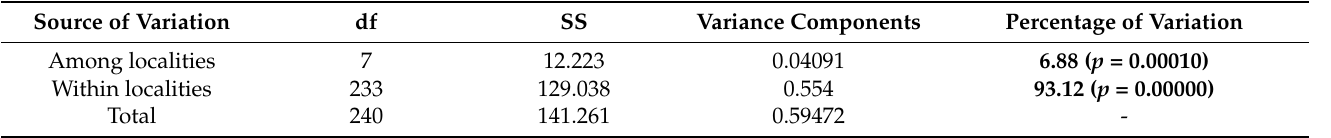
Table 1. Outcomes of AMOVA analysis based on the variability of the tRNA leu -cox2 intergenic region analyzed for 8 localities in Serbia: L, V, SP, T, S, Vr, DS and FG. Source of Variation df SS Variance Components Among localities Within